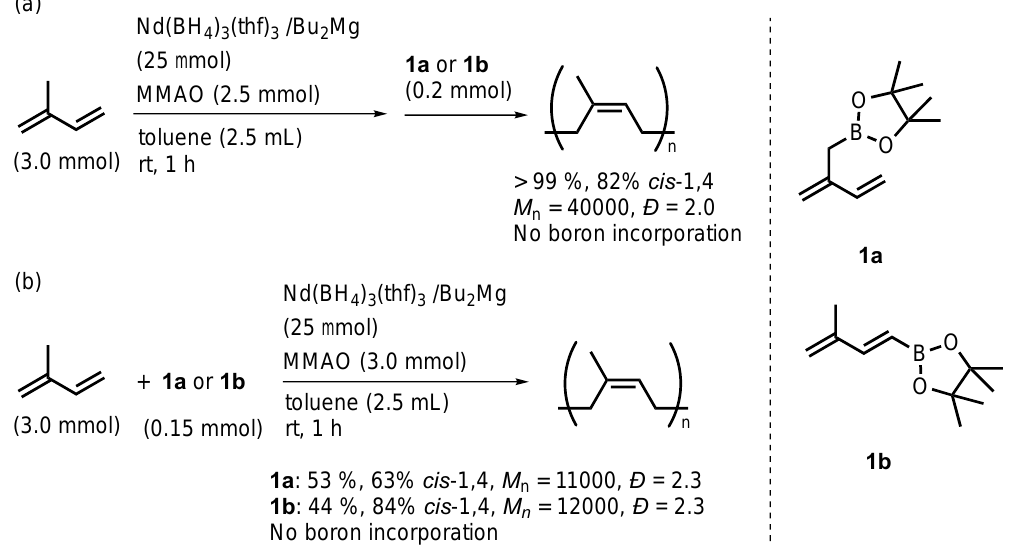
Scheme 1. Attempt for the chain-end functionalization into polyisoprene using boronic acid ester comonomers 1a and 1b via (a) post-functionalization and (b) copolymerization.